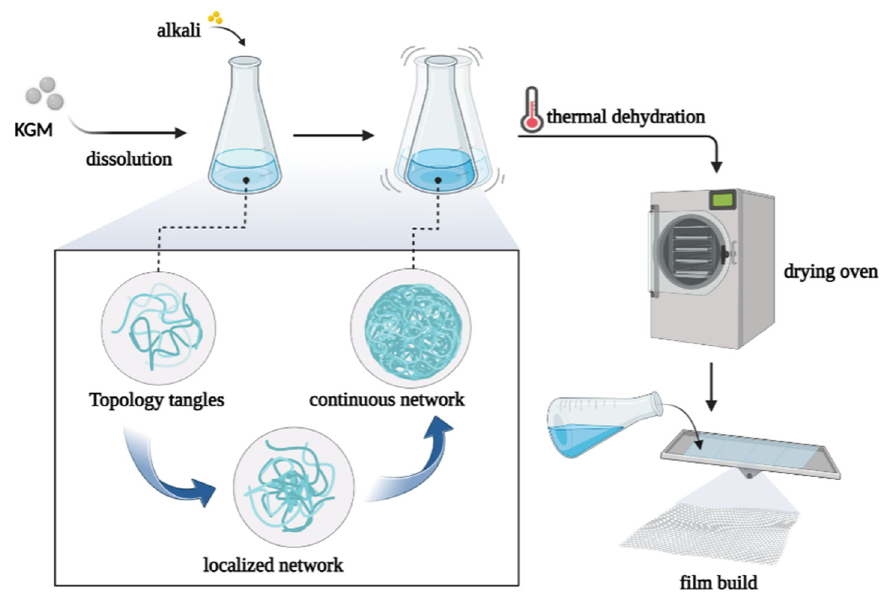
Figure 4. Alkali treatment causes the molecules of KGM to gather and form gels, which are then heated and dehydrated to obtain thin films.